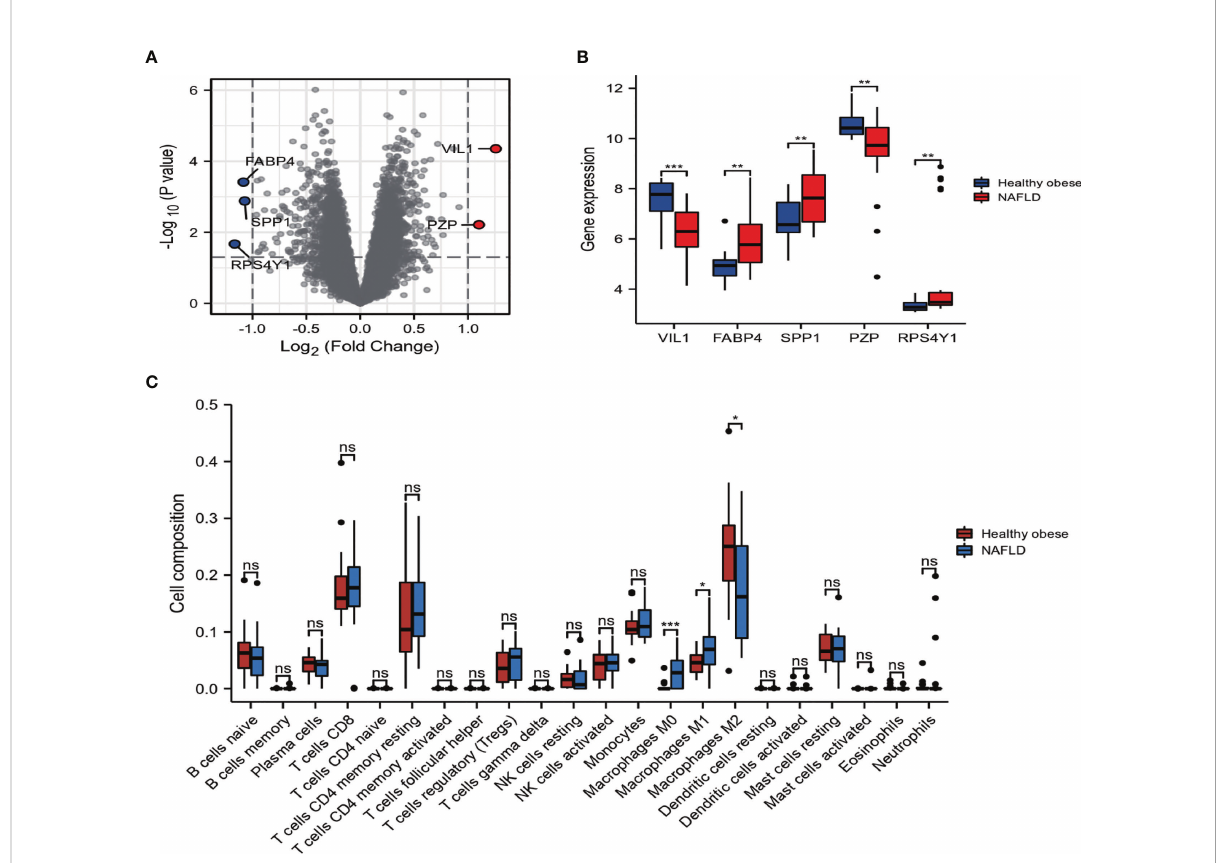
FIGURE 4 Expression and correlation analysis of the differentially expressed genes (DEGs). (A) DEGs in non-alcoholic fatty liver disease (NAFLD) and healthy obese samples in Gene Expression Omnibus (GEO) dataset. (B) The boxplot of fi ve DEGs. (C) Bar plot showing the difference between 22 in fi ltrated immune cells in the NAFLD and healthy obese groups with the CIBERSORT algorithm. Values are the mean ± SD. ns, no signi fi cance, *p < 0.05, **p < 0.01, ***p < 0.001 vs. the healthy obese